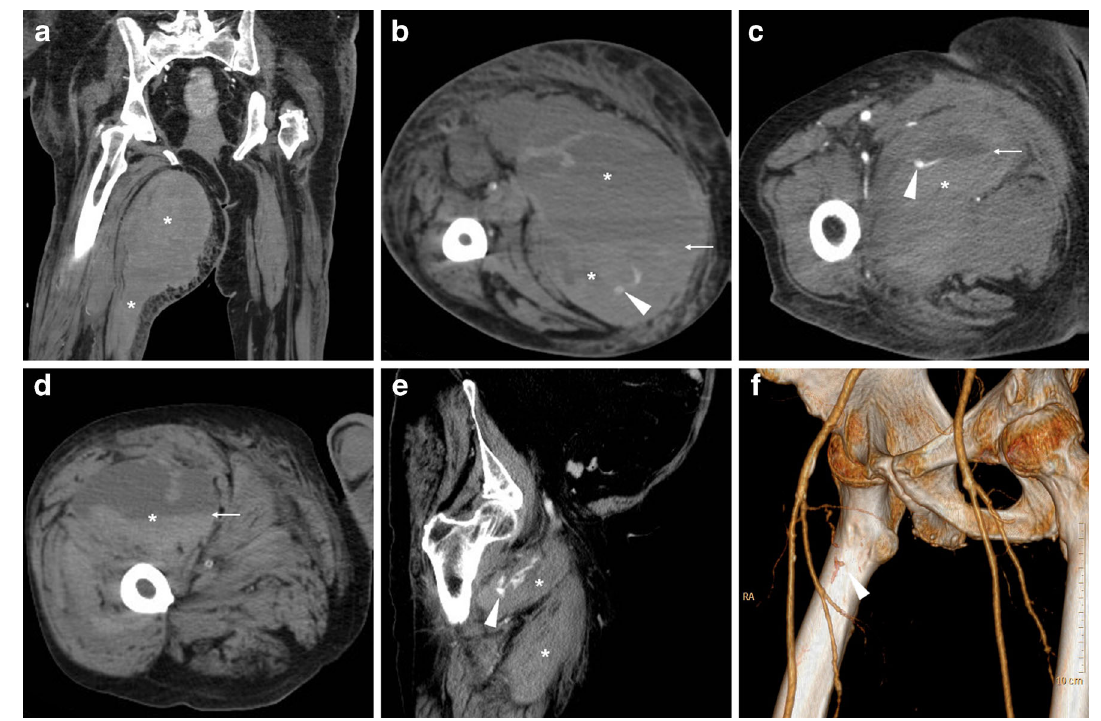
Fig. 3 Three cases of thigh muscle haemorrhages. A-B) Large, actively bleeding haematoma (*) following percutaneous coronary intervention (PCI), occupying the entire medial muscular compartment of the right thigh, with mixed attenuation values and fluid-fluid level (thin arrow in B) and active CM extravasation (arrowhead in B). C) Sizeable (8 × 5 cm) adductor muscle haematoma of the right thigh after CA, with fluid-fluid